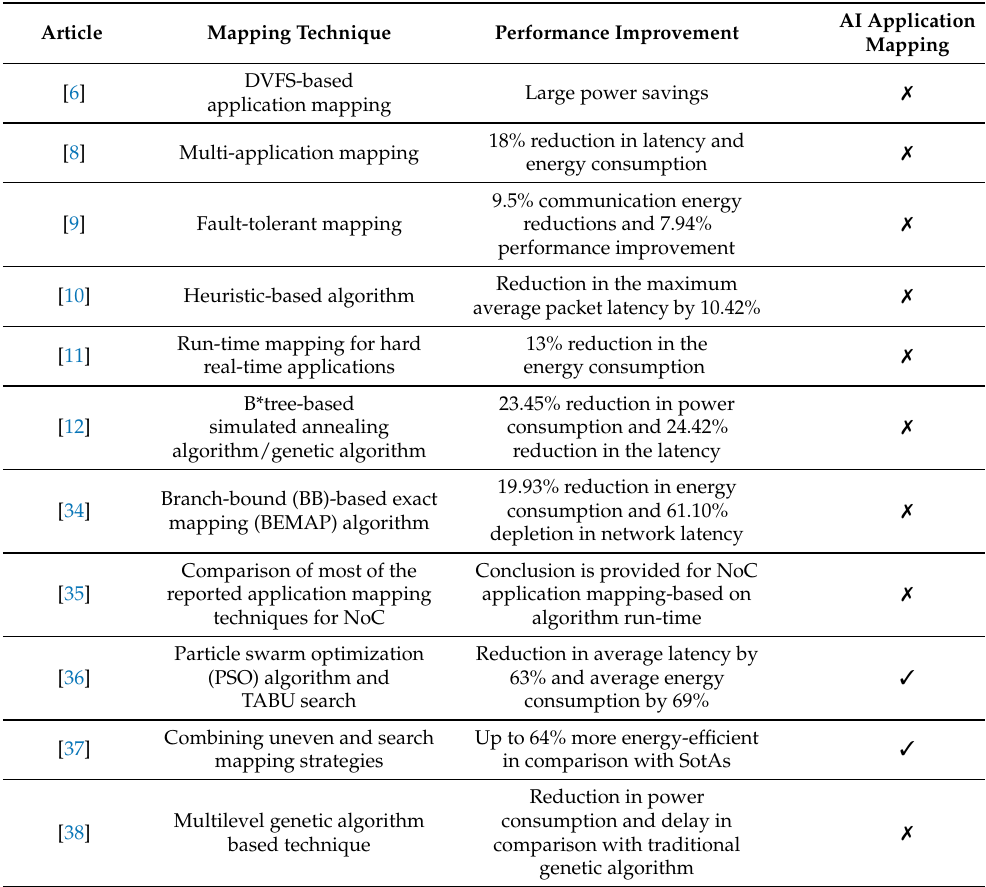
Table 2. Comparison of the recent